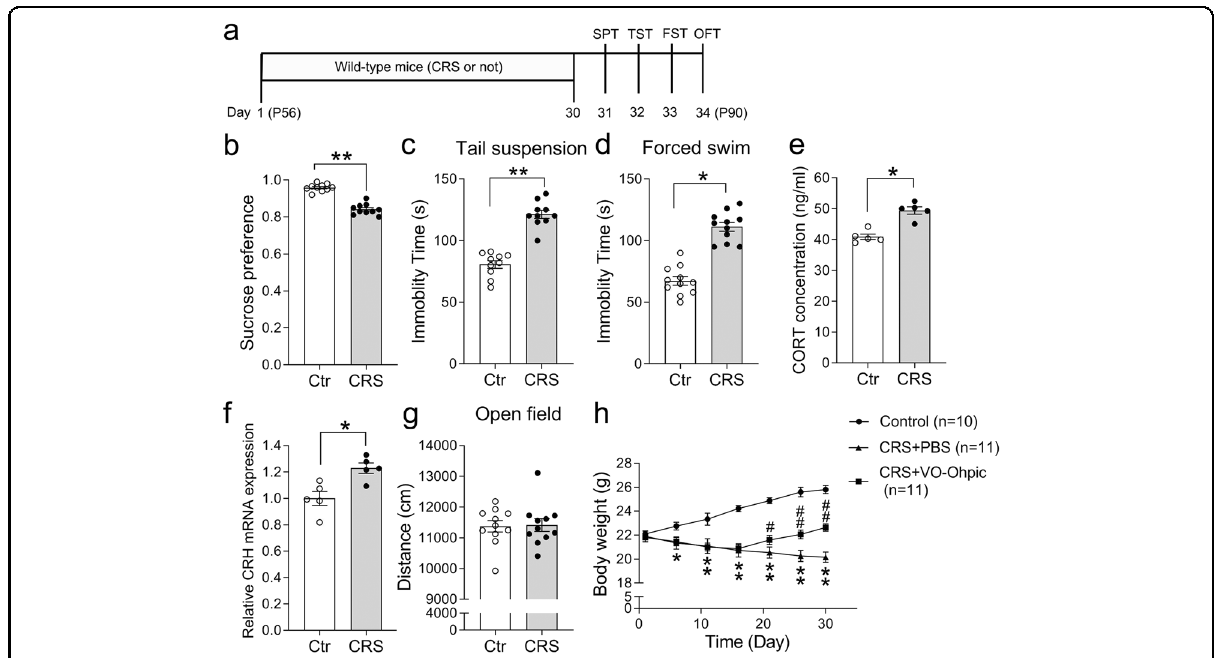
Fig. 1 CRS treatment induces depression-like behaviors and elevates HPA activity. a Diagram of experiment design and timeline. b – d The CRS treatment resulted in decreased sucrose preference ( b ) and increased immobility time in the TST ( c ), and FST ( d ). n = 10 for each group in sucrose preference test and TST, n = 11 for each group in FST. e , f The CRS treatment signi fi cantly increased the serum levels of CORT ( e ) and transcription levels of CRH in the PFC ( f ). g There were no signi fi cant changes in the total traveled distance in the OFT. n = 11 for each group. h A signi fi cant difference was observed in the body weight between CRS-treated mice and control mice during the 30-day period, but the reduction of body weight in CRS-treated mice could be partially reversed when PTEN inhibitor VO-Ohpic was intraperitoneally injected once per day from day 15. All the data are presented as mean ± SEM. Data were analyzed using Student ’ s t -tests ( b – g ) and two-way repeated measures ANOVA ( h ). * p < 0. 05, ** p < 0.01 (control mice versus CRS-treated mice); # p < 0.05, ## p < 0.01 (CRS-treated mice versus CRS-treated mice with VO-Ohpic). CRS, chronic restraint stress; FST, forced swim test; OFT, open- fi eld test; SPT, sucrose preference test; TST, tail suspension test; VO-Ohpic, VO-Ohpic